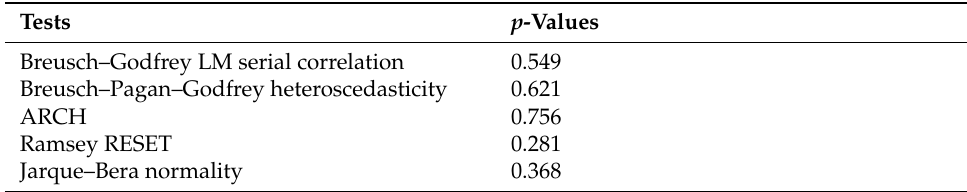
Table 6. Results of diagnostic tests for DYARDLS